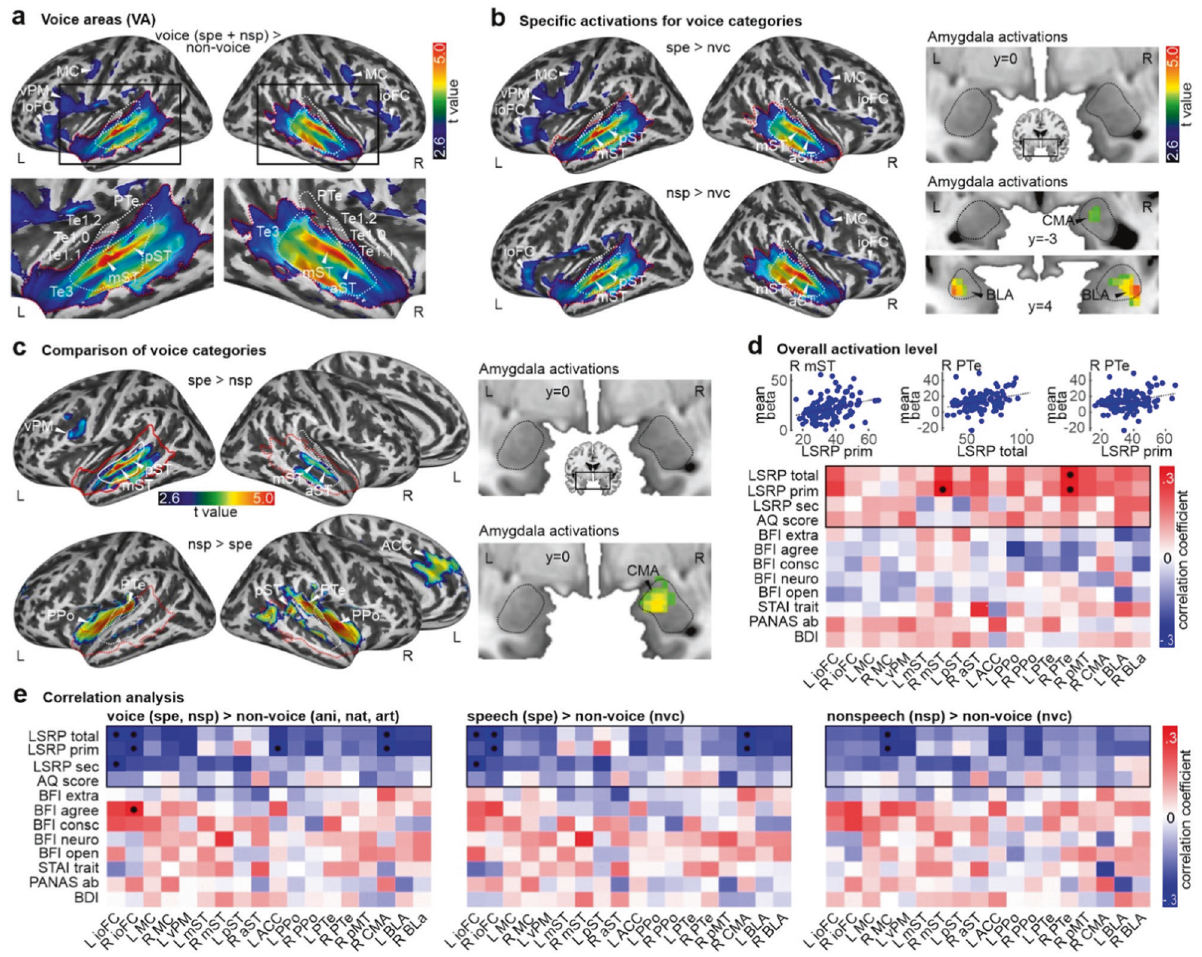
Fig. 2 Functional activations for voice compared to non-voice sounds. a Bilateral frontal (IFC, MC) and temporal cortex activity (mST, pST) for voice compared to non-voice sound ( n = 113). Lower panel shows an enlarged view of the section with the black rectangle in the upper panel, indicating peak locations in the AC (auditory cortex) located in the higher-order auditory area Te3. Dashed white outlines indicate primary AC (Te10 – 1.2), secondary AC (PTe), and higher-order AC (Te3); red dashed outline indicates the temporal voice area (VA). All activations are thresholded at a combined voxel threshold p < 0.005 and cluster level threshold k > 55, resulting at p < 0.05 corrected at the cluster level. b Functional activity ( n = 113) separately for the voice sound categories, namely speech sounds (spe) and non-speech sounds compared against non-voice sounds (nvc). Left panels show cortical activity, right panels show activity in the amygdala and its subregions ( CMA centromedial amygdala, BLA basolateral amygdala). c Functional activity ( n = 113) for comparing voice sound categories against each other, namely speech (spe) against non-speech sound (nsp) (upper panel), or vice versa (lower panel). d Correlations between personality traits and mean brain activity to all 5 sound categories ( n = 113). The upper panel shows the three signi fi cant correlations between activity in peak activity locations (as derived from a – c ) and LSRP total and primary score; lower panel shows all correlations ( ● p < 0.05, FDR corrected). e Pearson correlation ( n = 113) between personality traits and difference scores of peak activity locations for comparing voice against non- voice sounds (left panel), speech against non-voice sounds (mid panel), and non-speech against non-voice sounds (right panel). ACC anterior cingulate cortex, aST anterior superior temporal cortex, BLA basolateral amygdala complex, CMA centromedian amygdala complex, ioFC infero-orbital frontal cortex, MC motor cortex, mST mid superior temporal cortex, pMT posterior middle temporal cortex, PPo planum polare, PTe planum temporale, pST posterior superior temporal cortex, vPM ventral premotor cortex, nsp non-speech sounds, nvc non-voice sounds, spe speech sounds, voc voice negative associations were also repeated when using the LSRP prim score as a predictor (Fig. 3b, Table. S12). The same analysis was also performed with comparing the speci fi c voice subcategories (speech, non-speech) against non-voice sounds (Fig. S4), with some differential laterality effects for speech and non-speech sounds in association with LSRP scores. We then performed the same multiple regression analysis with the AQ score as the predictor variable and the other personality scores as regressors of no interest (Fig. 4, Table. S13). We found that only a small number of regions were negatively associated with autistic personality scores and their in fl uence on neural voice processing. We found negative association speci fi cally in bilateral analyses revealed any signi fi cant neural activations, thus pointing